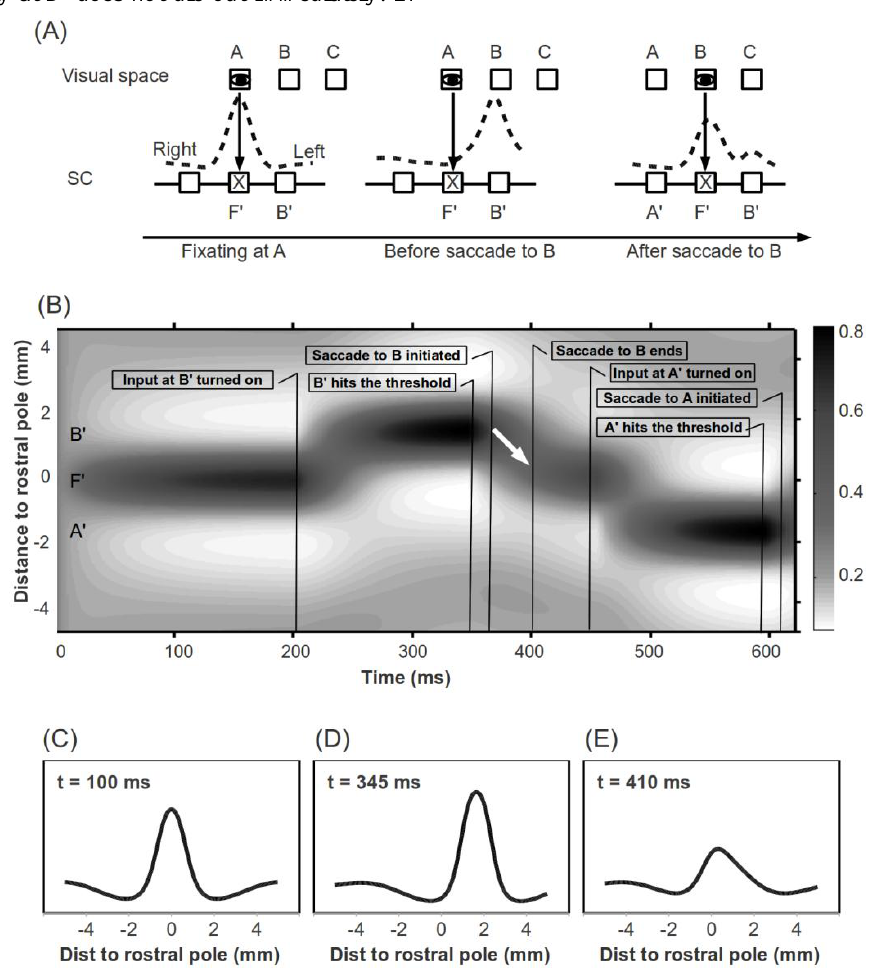
Figure 1 (A) Remapping of space in the SCi after a saccade results in asymmetric activation. Eyes mark the fixated spatial location. X's mark the rostral pole of the SCi. For convenience, the right colliculus is drawn on the left. (B) Illustration of a sample simulation trial. On the Y-axis, positive and negative values denote the right and left colliculi, respectively. The white arrow marks a hill of activity “moving” toward the rostral pole during the first saccade. (C), (D) and (E) Network activity during active fixation (t = 100 ms) shortly before a first saccade is initiated (t = 345 ms) and shortly after this saccade ends (t = 410 ms). The scales on the X axis denote distance from the rostral pole (mm). As clearly shown in (E), the SCi is asymmetrically activated shortly following a saccade, as illustrated in